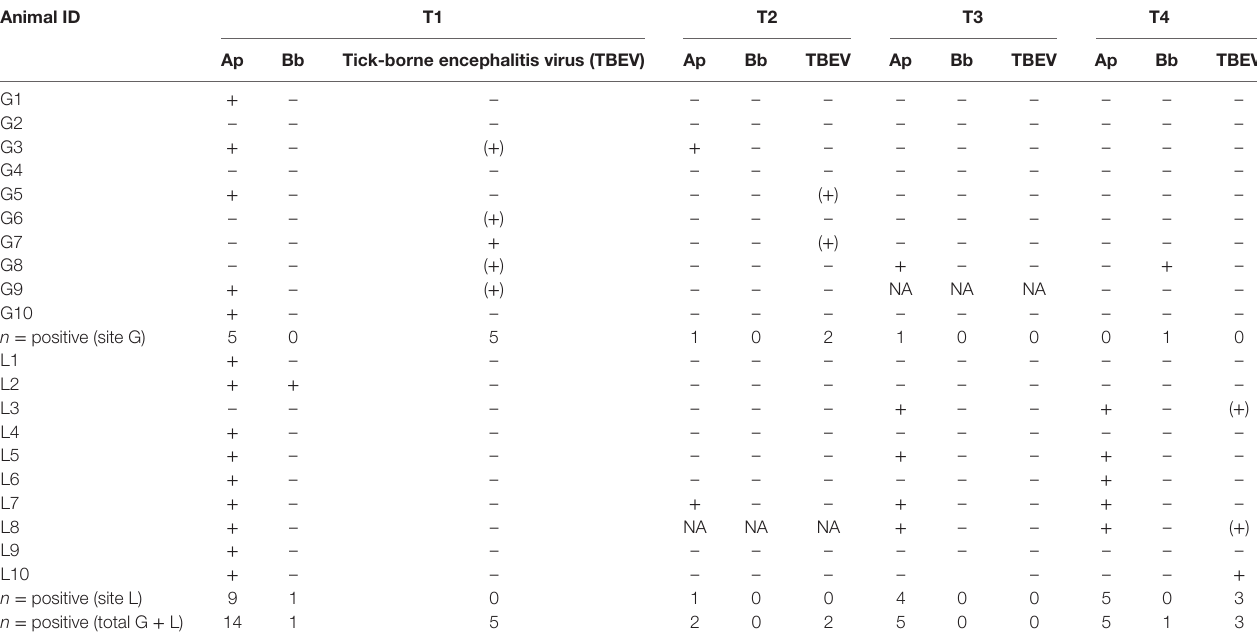
TaBle 1 | Results of serological